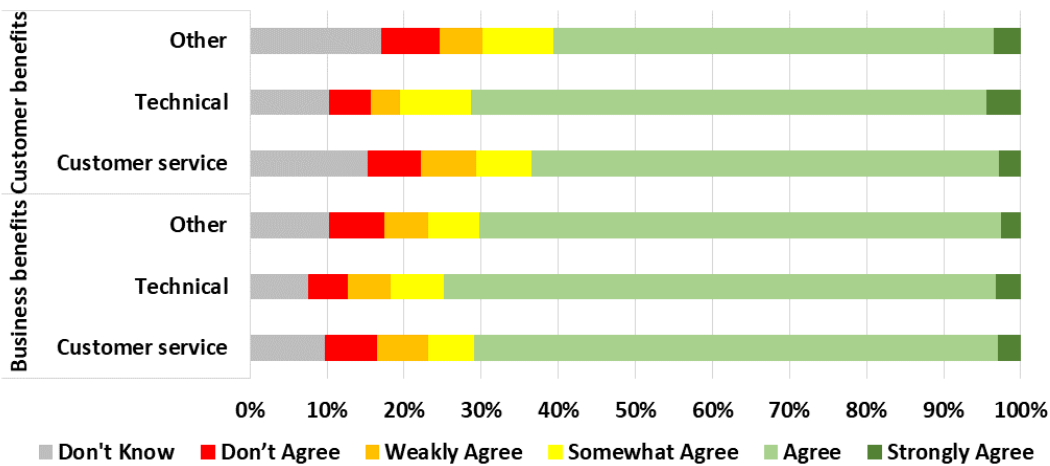
Figure 4. Within each beneficiary group (y-axis), depending on the type of the experts’ job roles (inner y-axis): the relative percentage response (x-axis) for each agreement level (colour).